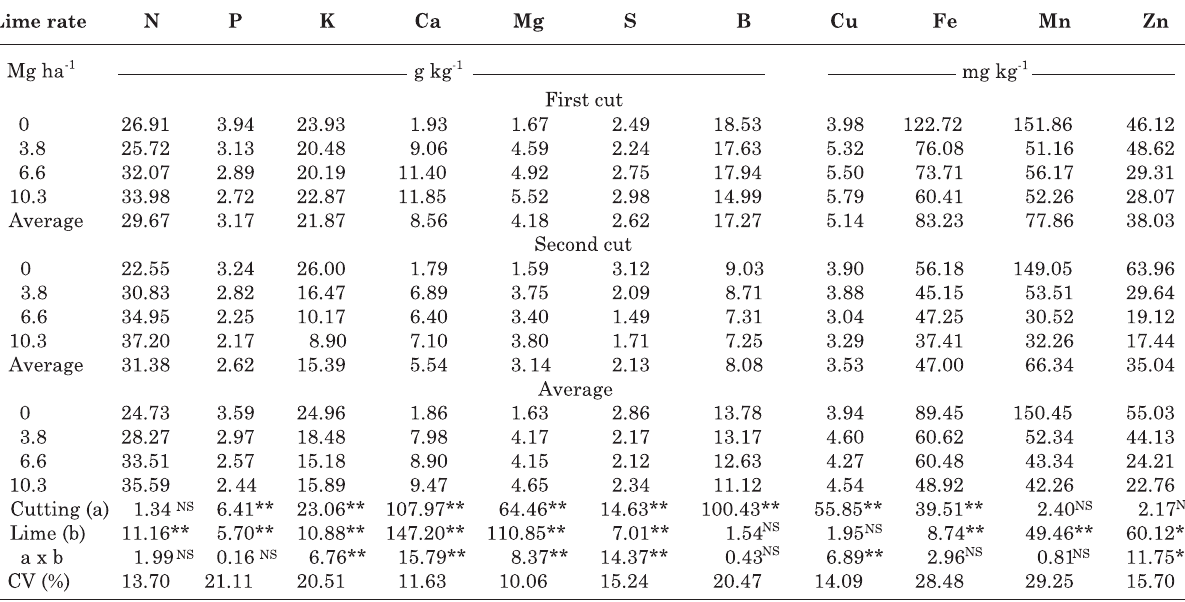
*, **, NS significant at 5 and 1 % and non significant, respectively.